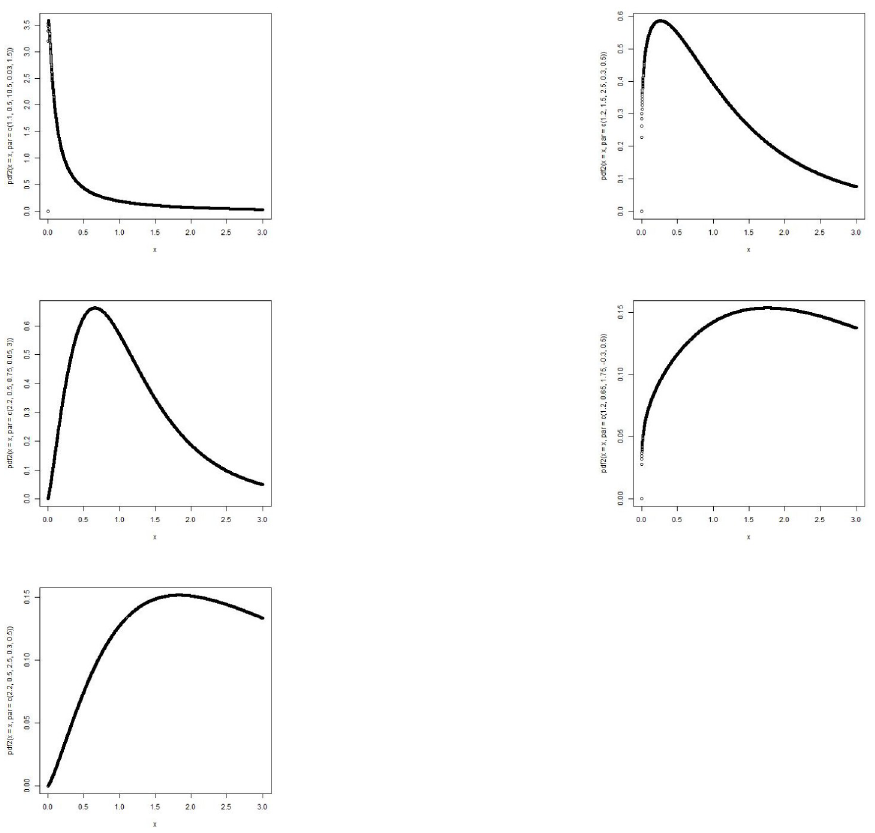
Fig 5. Graphs of p.d.f of MBTL with various parameter